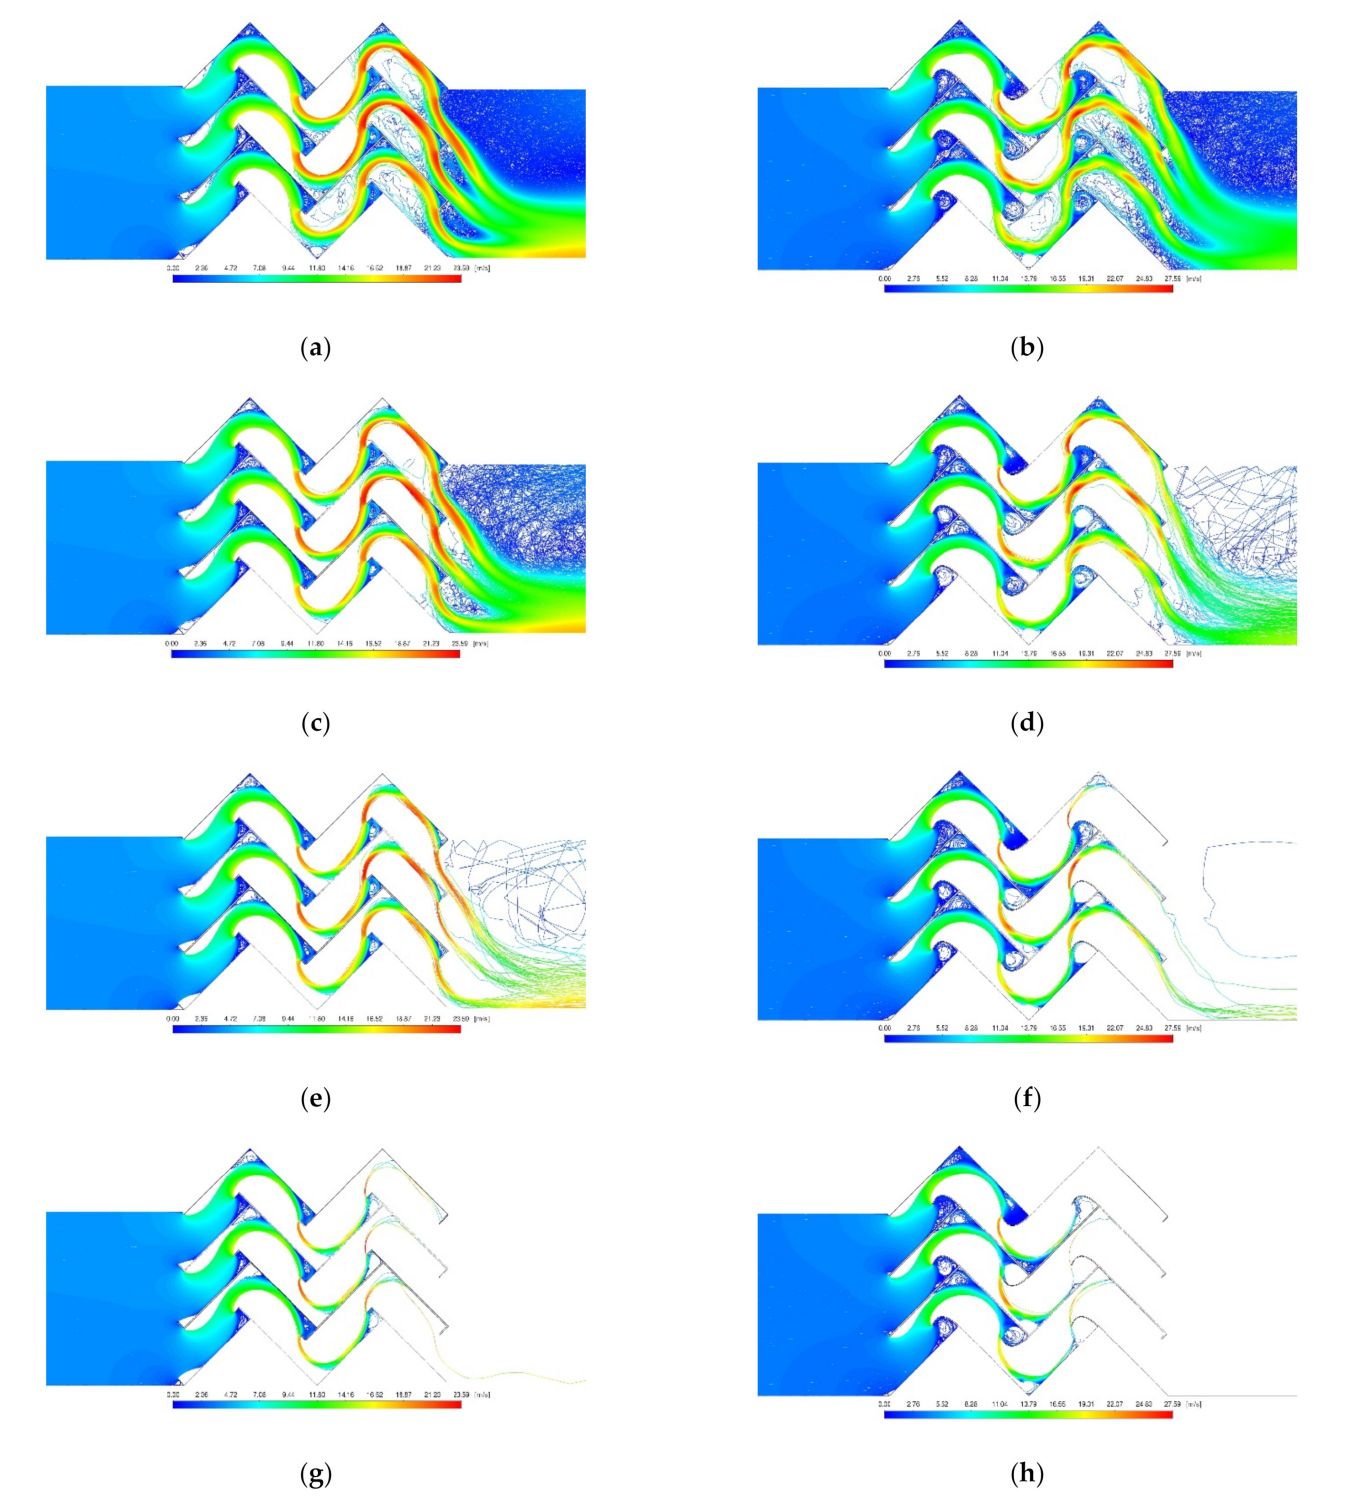
Figure 22. Droplet trajectories for geometries B_15_0 ( a , c , e , g ) and C_15_0 ( b , d , f , h ) for velocity 4 (m s − 1 ) and droplet diameters: 6 ( µ m) ( a , b ); 8 ( µ m) ( c , d ); 10 ( µ m) ( e , f ); 12 ( µ m) ( g , h